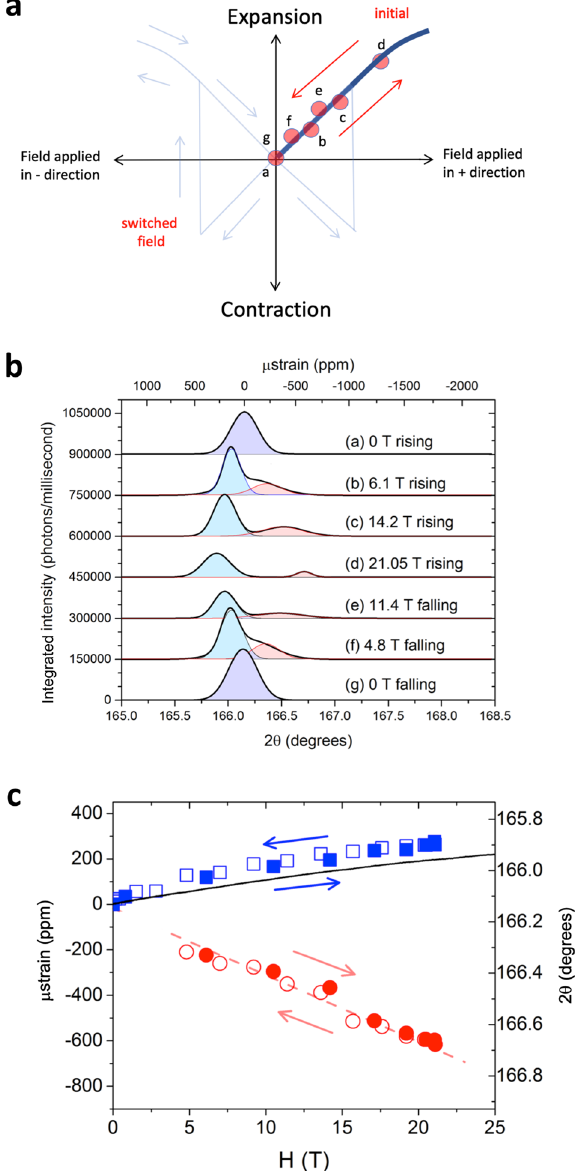
Fig. 2 The magnetostriction in the antiferromagnetic state of UO 2 — one fi eld direction. a A schematic diagram showing the bulk sample magnetostriction along the <111> direction to a magnetic fi eld applied repeatedly to it in the same direction (bold blue line), showing the sample reversibly expanding. A pale blue pattern shows fi eld dependence of the magnetostriction for positive and negative fi elds directions. b A waterfall plot of fi ts to the integrated intensity along 2 θ of selected fi elds and at 15K. The peak at lower 2 θ (blue) corresponding to expansion is much larger than the peak at higher 2 θ (red). c The peak positions of the two peaks at 15K, with fi lled symbols corresponding to rising fi eld and open symbols to falling fi eld. Red circles represent the smaller peak and blue squares the larger one. The blue peak and its positive magnetostriction can be seen to match previous magnetostriction measurements using the fi ber Bragg grating technique (black line), with about a 150p.p.m. expansion at the maximum 21.1T applied fi eld. The red dash line is guide to the